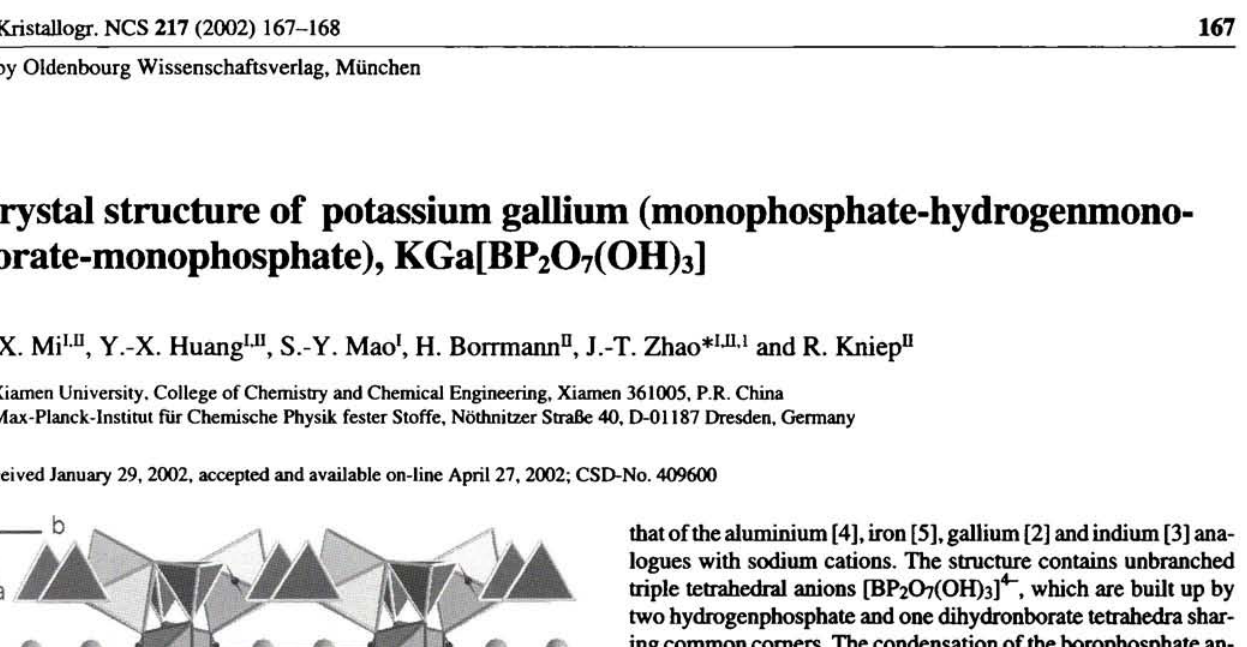
Table 1. Data collection and handling.